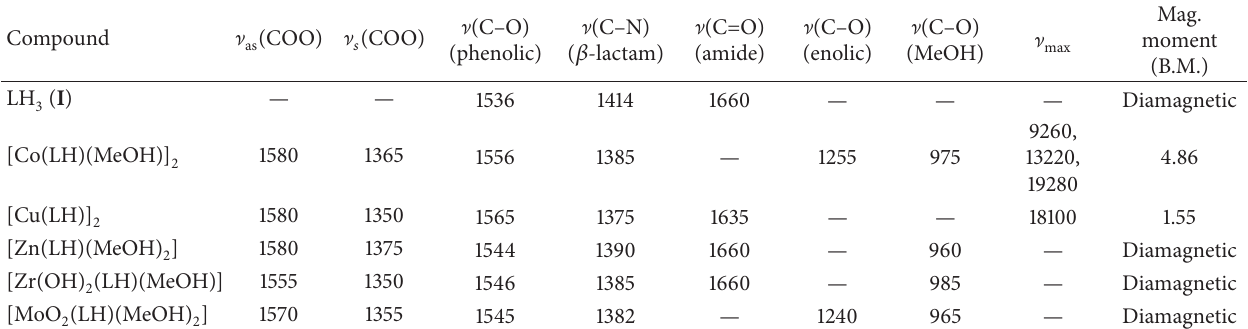
Table 2: IR, reflectance spectral data (cm − 1 ), and magnetic moments of coordination compounds of I .